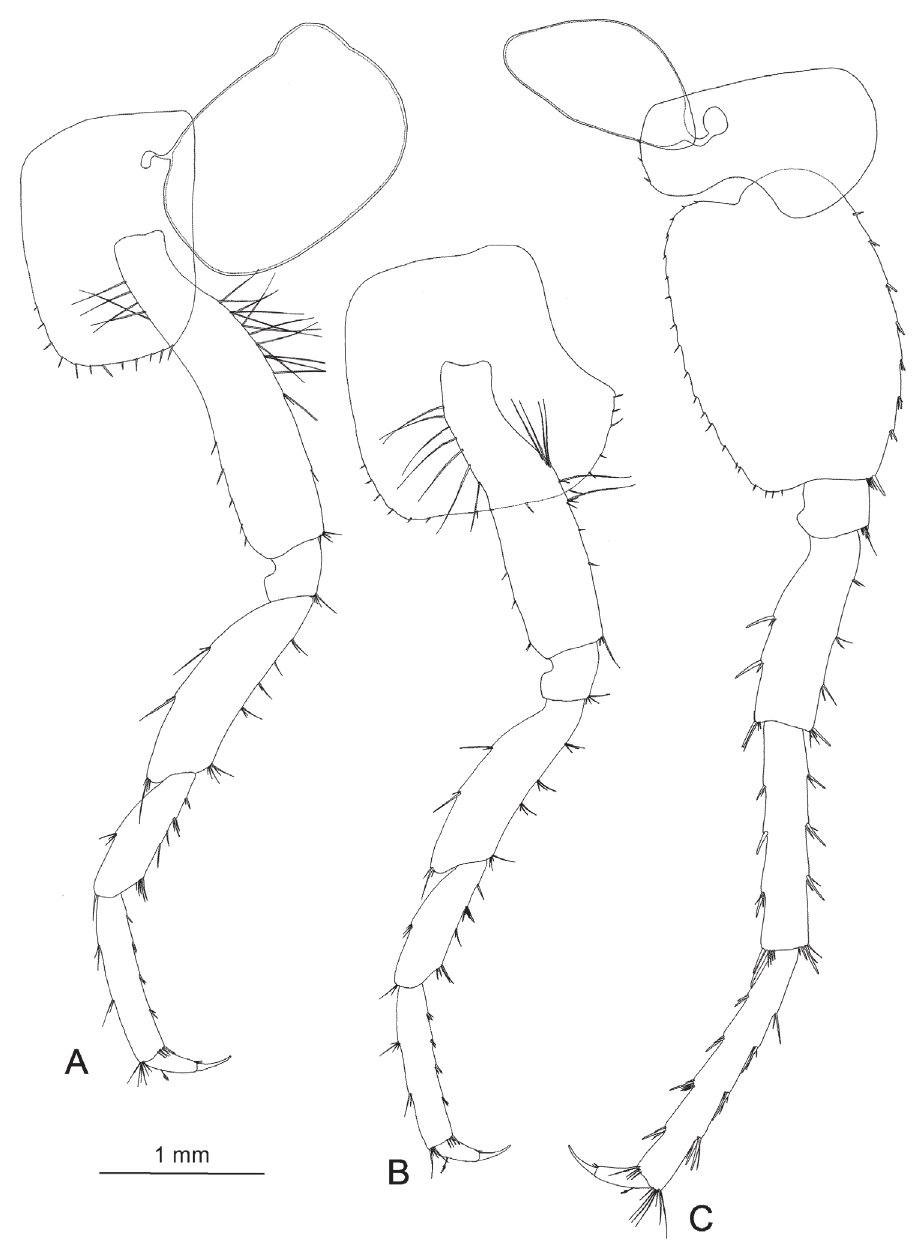
Figure 10. Niphargus enslini , male from the Blätterteighöhle A pereopod III B pereopod IV C pereopod V (dactlylus